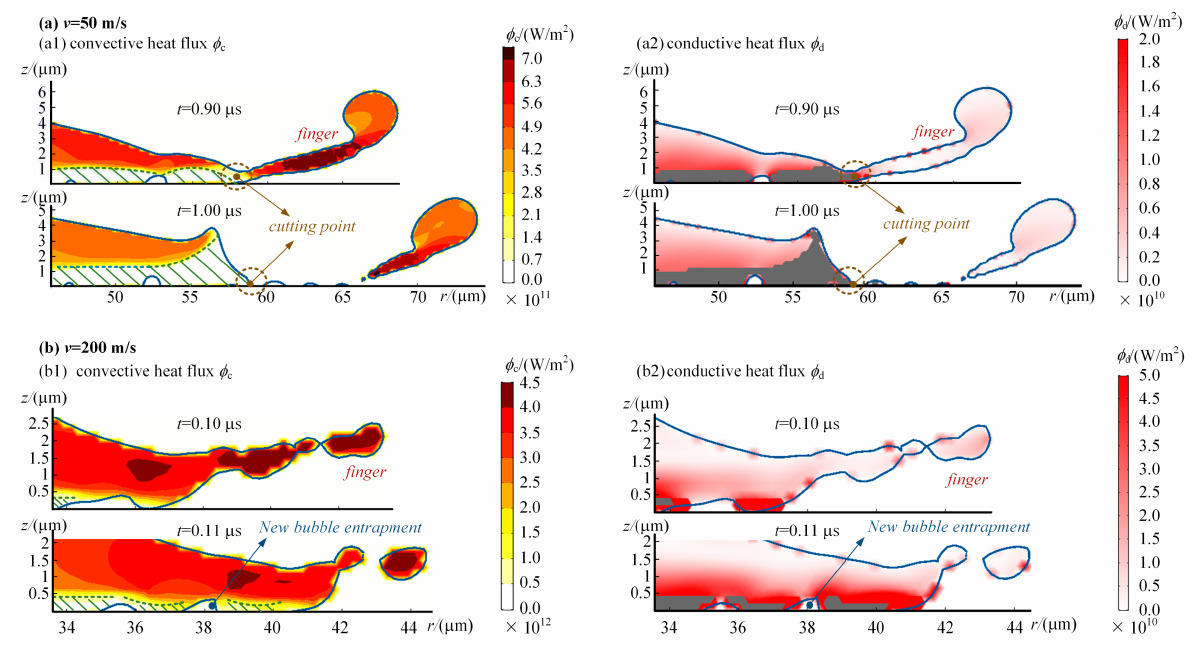
Figure 5. ( a ) Convective heat flux φ c and ( b ) velocity v & shear stress τ distribution of fall-back and cut-off splash, respectively. represents the mushy